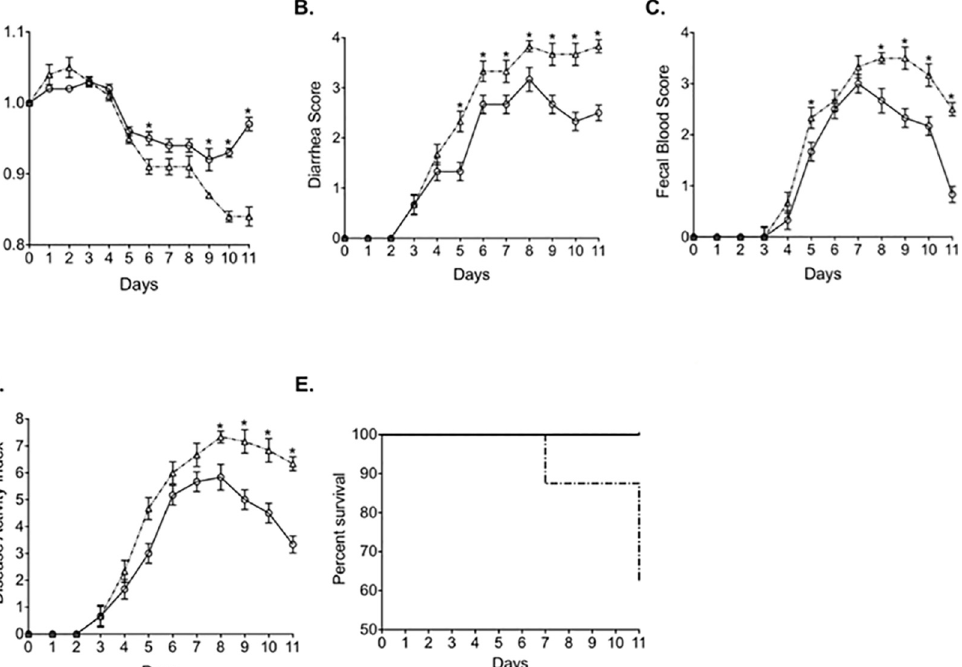
Fig 7. Dclk1 epithelial deletion increases disease activity following DSS-induced colitis. Both Villin Cre ;Dclk1 f/f and Dclk1 f/f mice were fed with 3% DSS in drinking water for 9 days followed by regular drinking water for 2 days to induce colitis (n = 8 for each group). A. Body weight. B . Diarrhea score. C . Fecal blood score. D . Disease activity index. E . Kaplan-Meier survival curve (dashed line = Villin Cre ;Dclk1 f/f , solid line = Dclk1 f/f ). Data are presented as the mean ± S.E.M. * p < 0.05 Villin Cre ;Dclk1 f/f vs Dclk1 f/f .